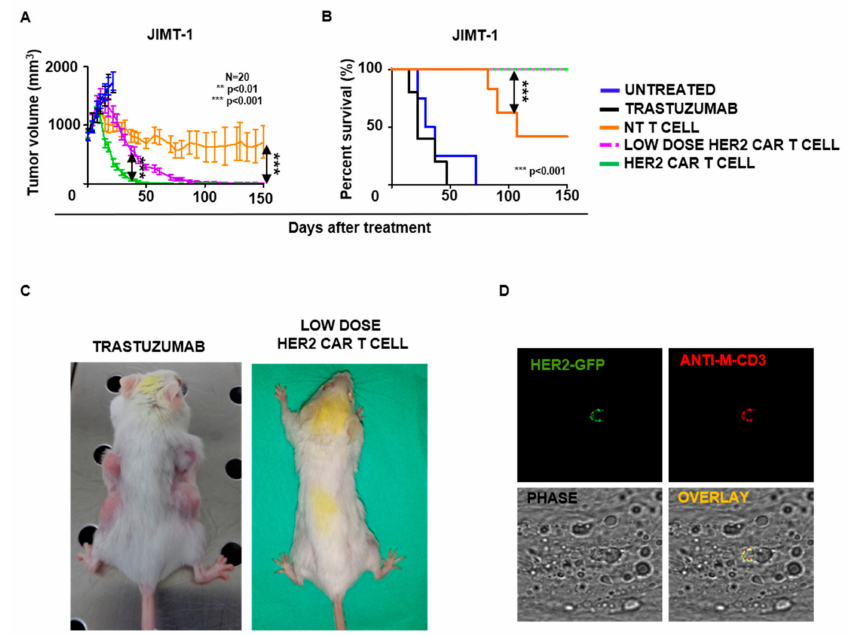
Figure 5. Antitumor activity of HER2-CAR mouse T cells in a xenograft model: ( A ) Quantitative measurement of tumor volumes (volume = mm 3 ; low dose HER2-CAR versus HER2-CAR groups: *** p < 0.001; NT T cell versus HER2-CAR groups *** p < 0.001). ( B ) Kaplan-Meier survival curve (NT T cell versus both HER2 CAR groups *** p < 0.001). ( C ) Representative images of animals. ( D ) Representative images for the detection of HER2-CAR mouse T cells in JIMT-1 xenografts (field of view: 92 µ m × 92 µ m). HER2-CAR mouse T cells were visualized by AlexaFluor647 conjugated anti-mouse CD3e and HER2-GFP